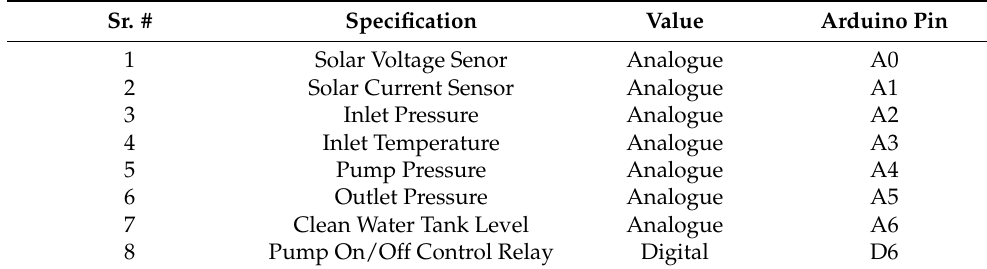
Table 9. Field instrumentation devices